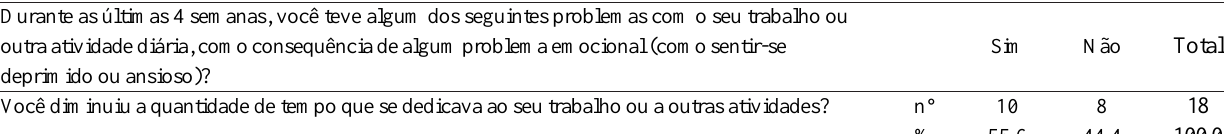
Tabela 5. Distribuição das frequências simples e relativas para questão do SF-36. Durante as últimas 4 semanas, você teve algum dos seguintes problemas com o seu trabalho ou deprimido ou